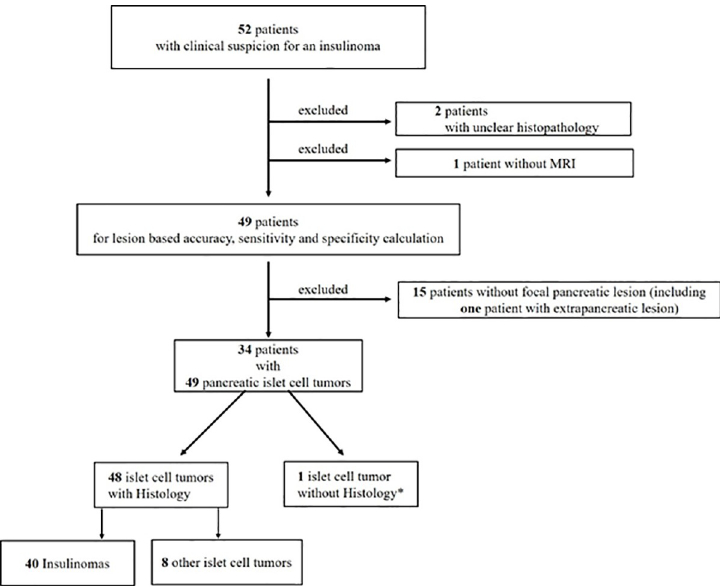
Fig 1. Study sample flow diagram. This is the outline of the selection of the final study sample with inclusion and exclusion criteria within the defined observation window. � 68 Ga-DOTA-Exendin-4 PET/CT served as reference standard. PICT = pancreatic islet cell